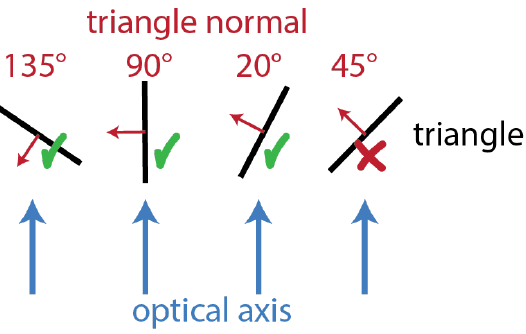
Figure 4. E ff ect of the CropBack Figure 4. Effect of the CropBack filter.